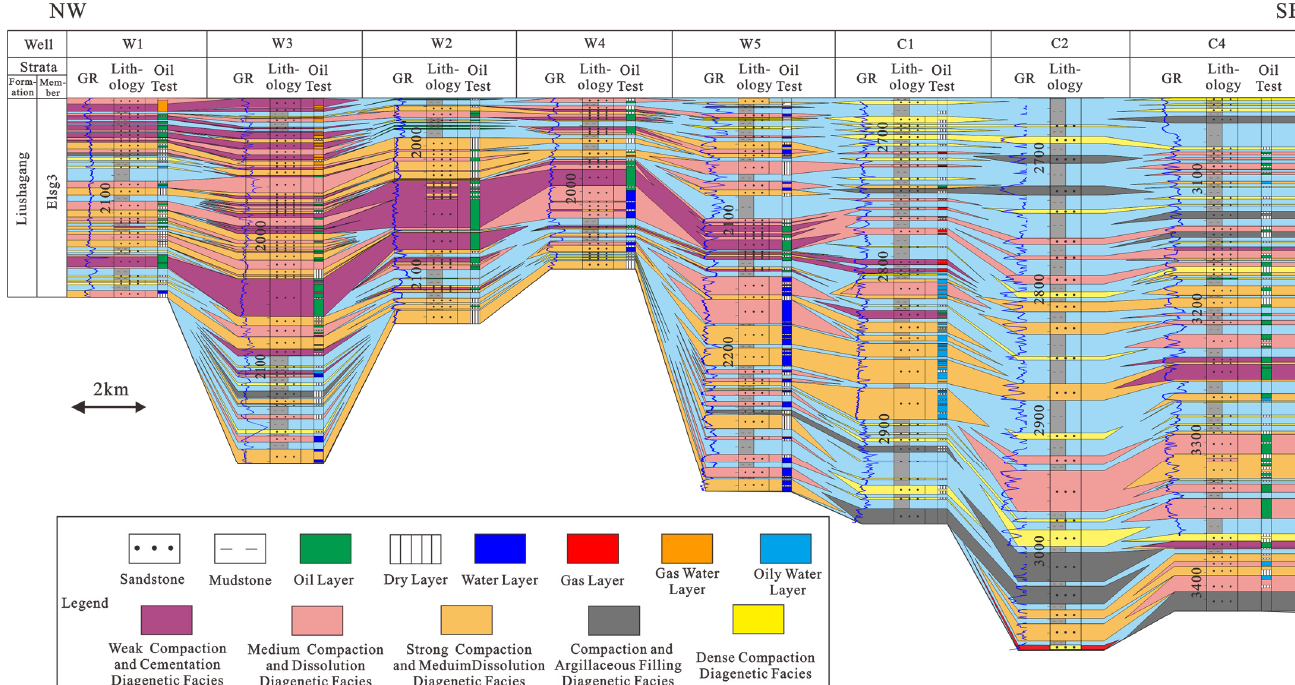
Figure 8. The diagenetic facies correlation section from wells W1 to C4 showing the diagenetic evolution of the west and middle areas in the Weixinan Sag (the section location is shown in Figure 1).